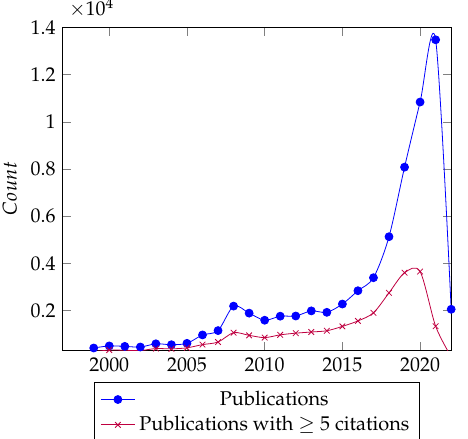
Figure 2. Google Trends’ interest over time for Machine Learning and industry 4.0.